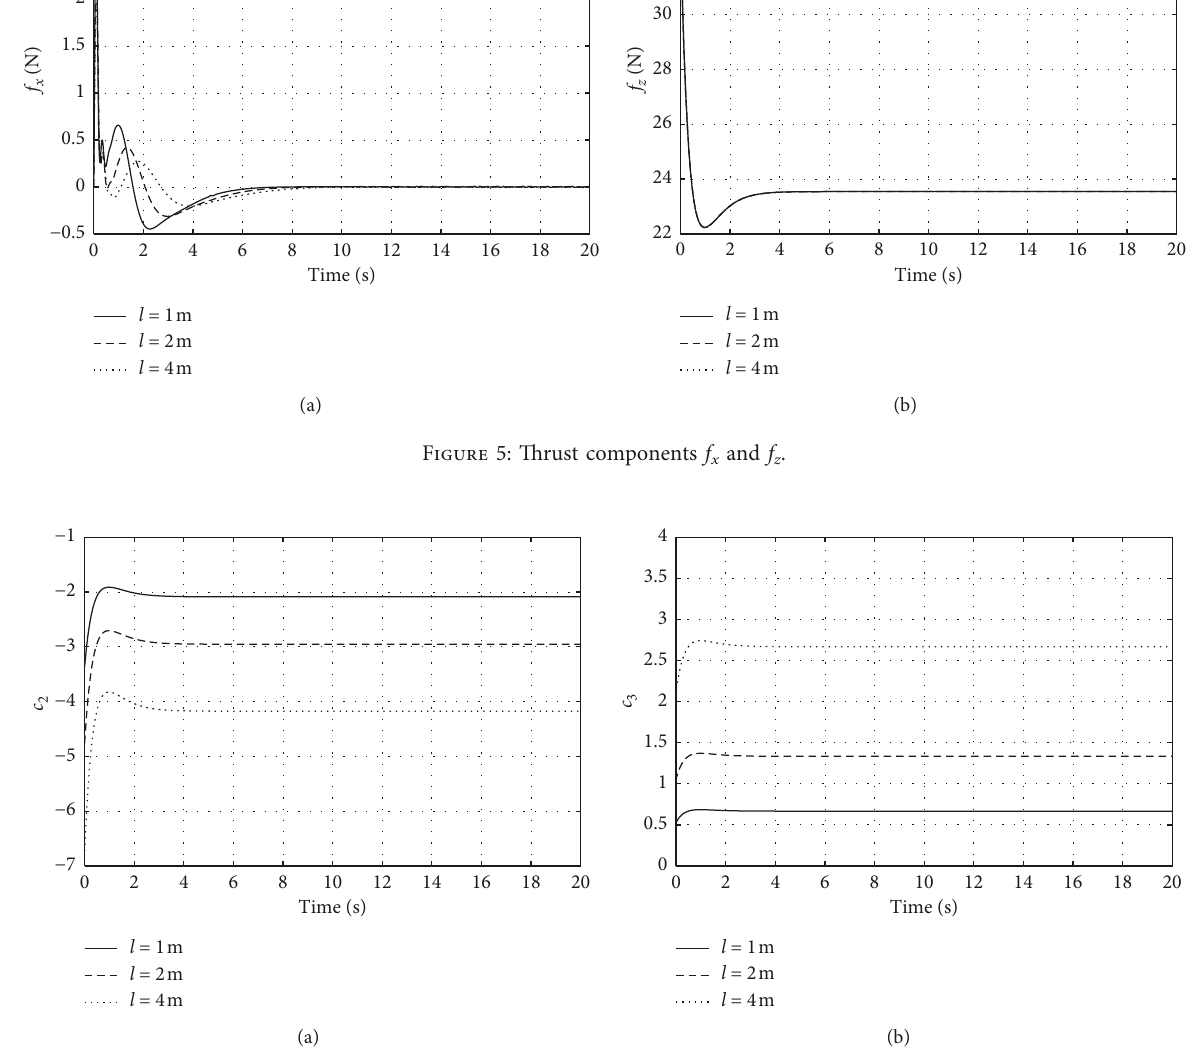
Figure 6: Sliding surface parameter c